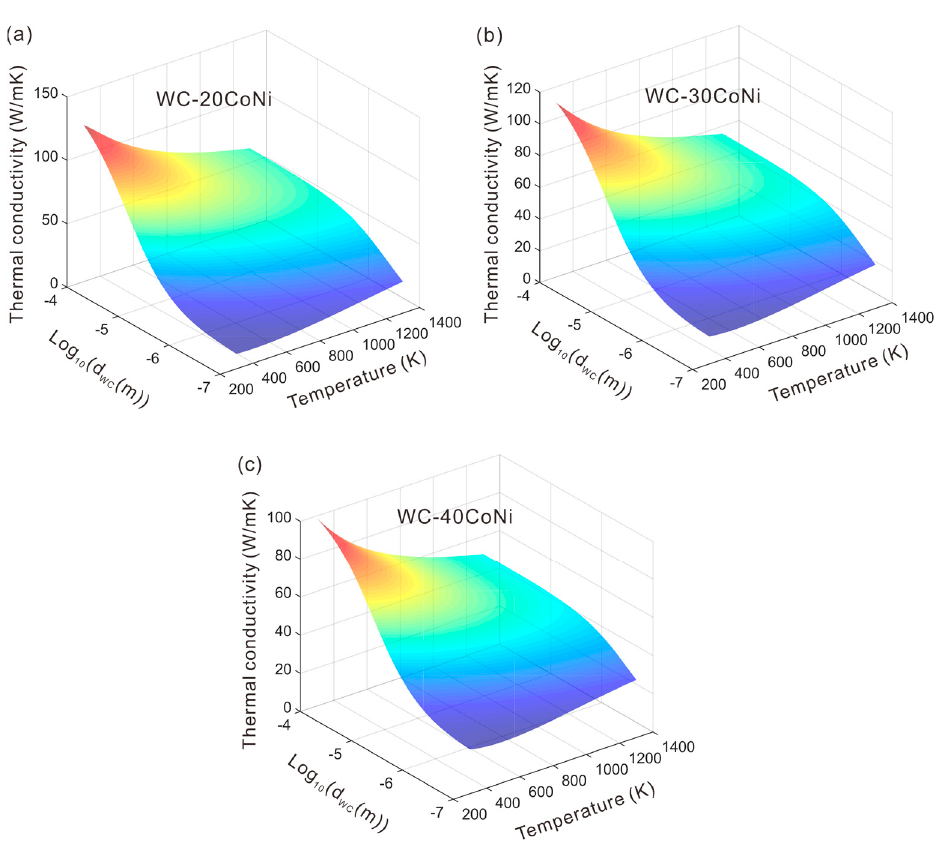
Figure 9. The model-predicted thermal conductivity vs. temperature and WC grain size at different phase compositions of: ( a ) WC-20 wt.% (Co, Ni); ( b ) WC-30 wt.% (Co, Ni) and ( c ) WC-40 wt.% (Co, Ni). The composition of (Co,Ni) binder phase is Co–50wt.%Ni.